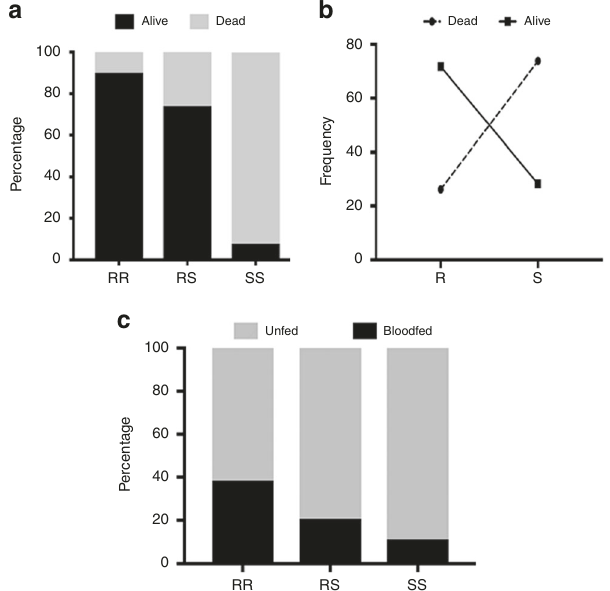
Fig. 5 Impact of the CYP6P9b -based metabolic resistance on bed nets ’ ef fi cacy. a Distribution of CYP6P9b genotypes between dead and alive mosquitoes after exposure to PermaNet 2.0 net in experimental huts showing that CYP6P9b_R signi fi cantly allows mosquitoes to survive exposure to this insecticide-treated net. b Association between frequency of CYP6P9b-R and ability to survive exposure to PermaNet 2.0. c Distribution of CYP6P9b genotypes between blood-fed and unfed mosquitoes after exposure to the PBO-based net PermaNet 3.0 showing that CYP6P9b_R allele increases the ability to take a blood meal. Source data are provided as a Source Data fi